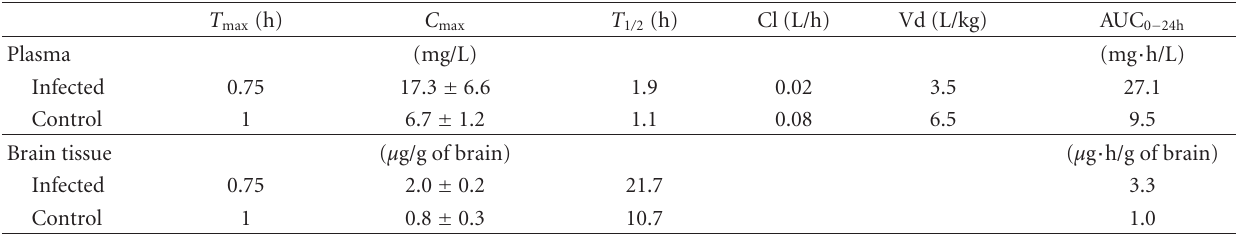
Table 2: Plasma and cerebral pharmacokinetic parameters after intraperitoneal administration of moxifloxacin (50mg/kg) in infected and control mice ( n =